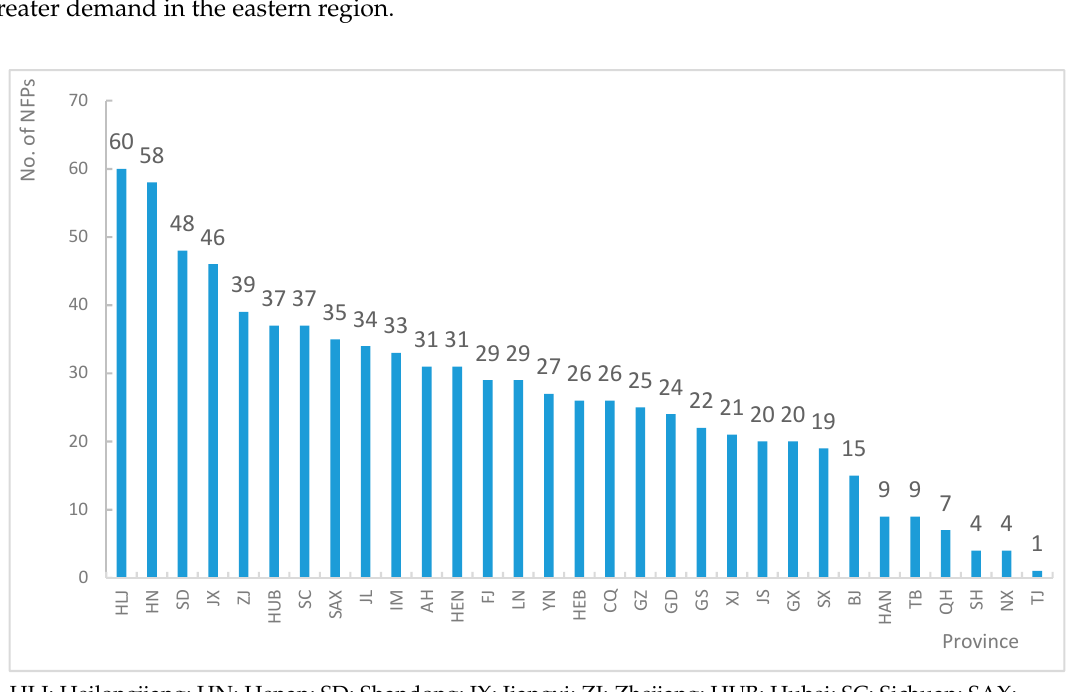
Figure 4. The number of NFPs in 31 provinces (status by the end of 2015). (Information collected from the official website of NFGA (http://www.forestry.gov.cn/)).